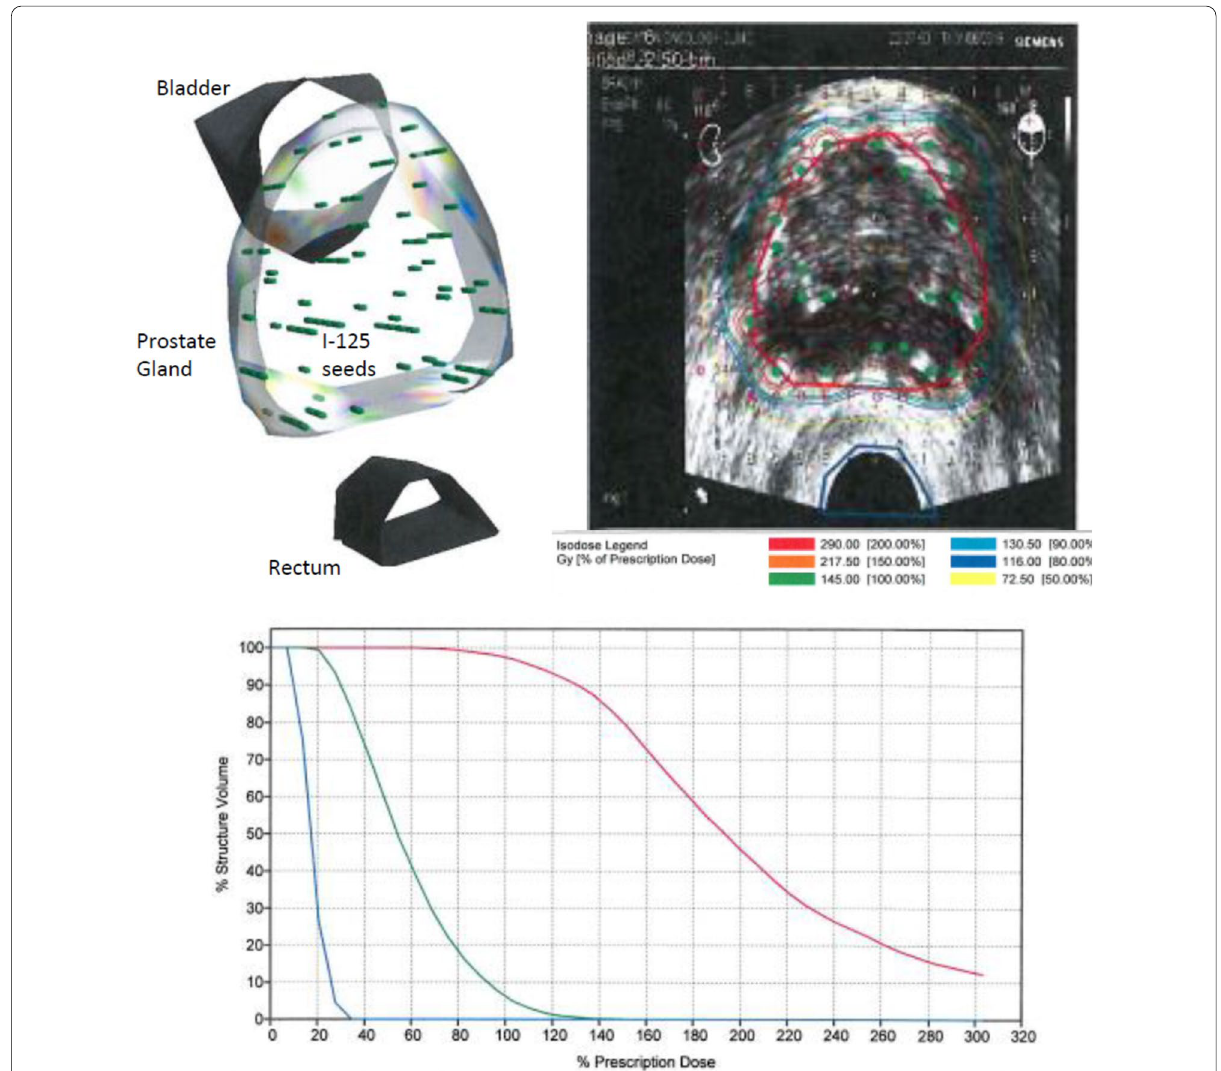
Fig. 4 Dose report for patient 1, seeds actual placements within prostate gland (top left), isodoses within prostate gland (top right) and DVH for prostate, bladder and rectum